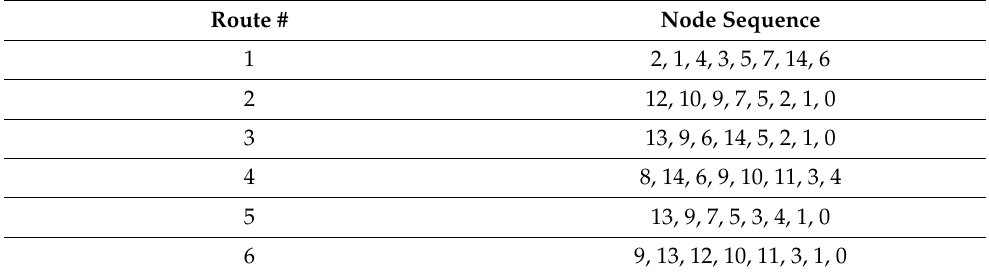
Table 4. Best Route Set for 6-Route Case.